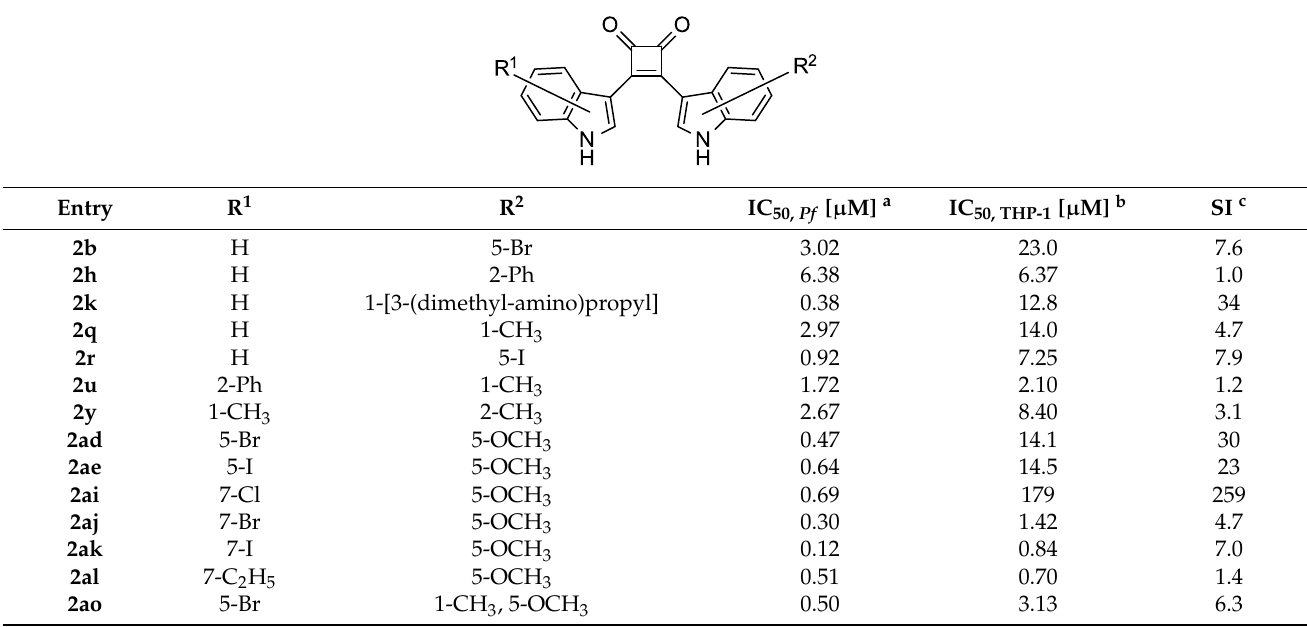
Table 2. Selectivity of the most active bisindolylcyclobutenediones on P. falciparum parasites versus the human THP-1 cell line.